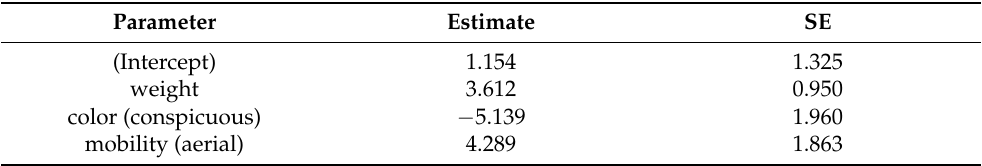
Table 3. Selected Linear Generalised Mixed Model (GLMM) showing the variables explaining the difference between (a) the number of poisoned individuals included in the “Ant í doto Programme” database and (b) the number of individuals recorded consuming baits during the field experiment. The estimates of the parameters (including the sign) and the standard error of parameters (SE) are